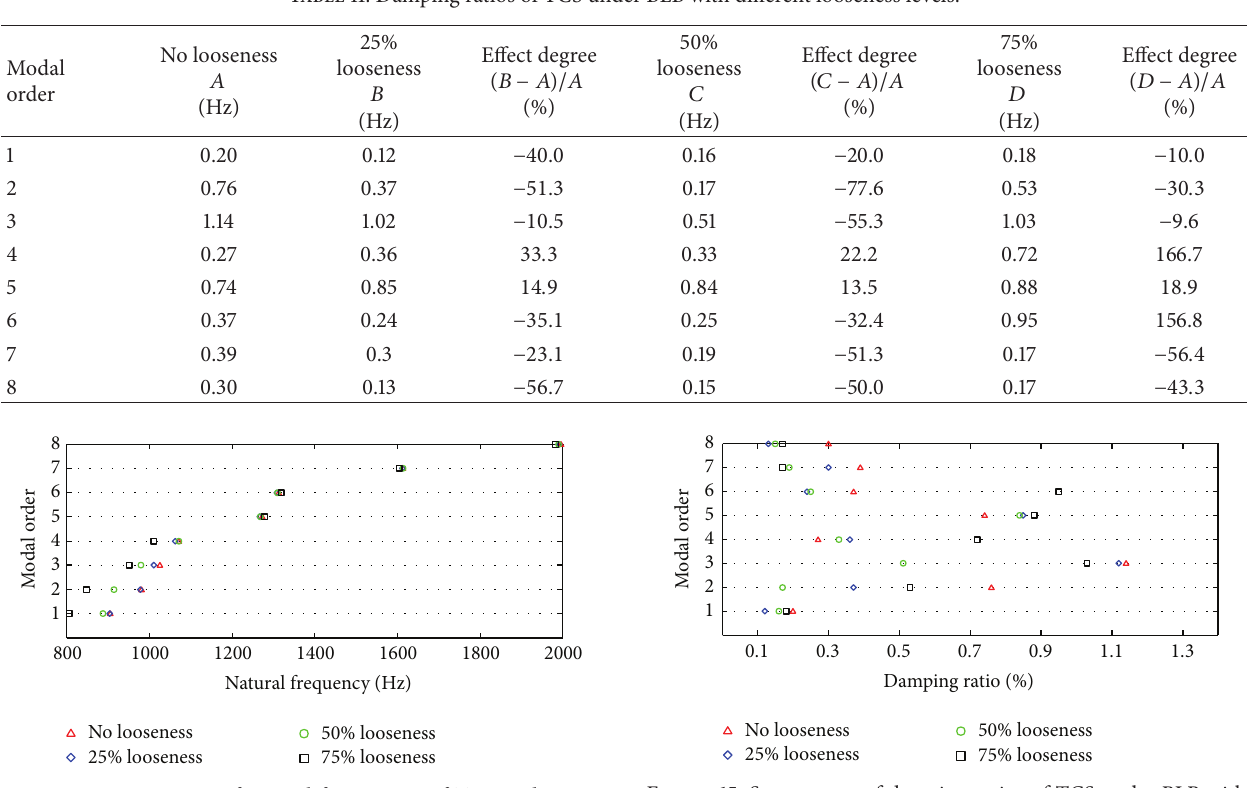
Table 11: Damping ratios of TCS under BLB with different looseness levels.